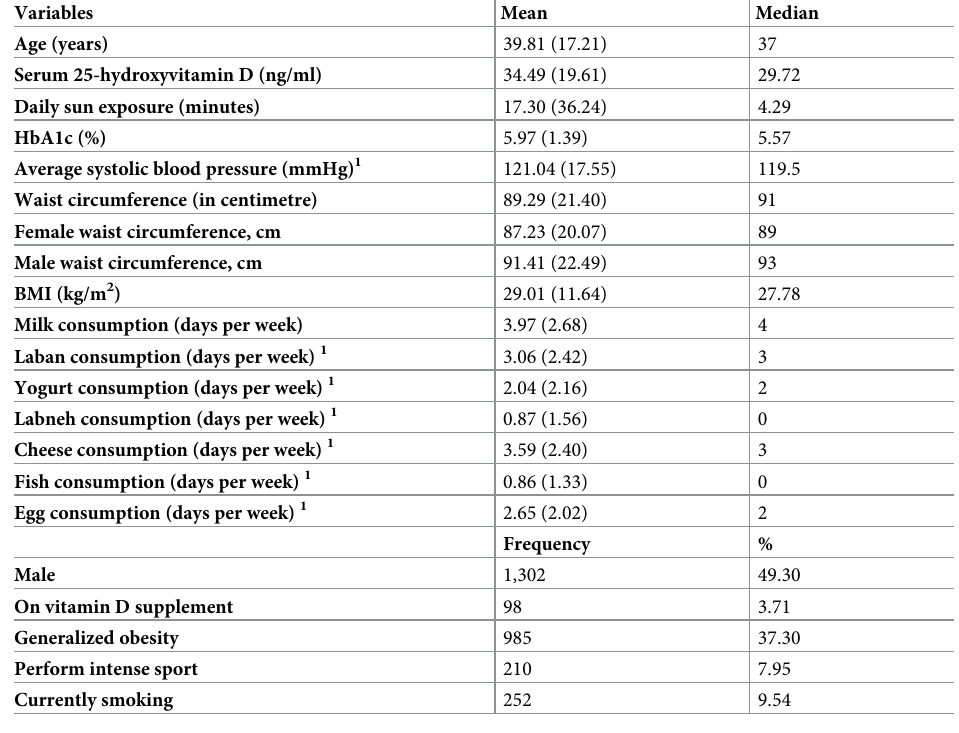
Table 1. Descriptive statistics of the sample (n = 2,641).